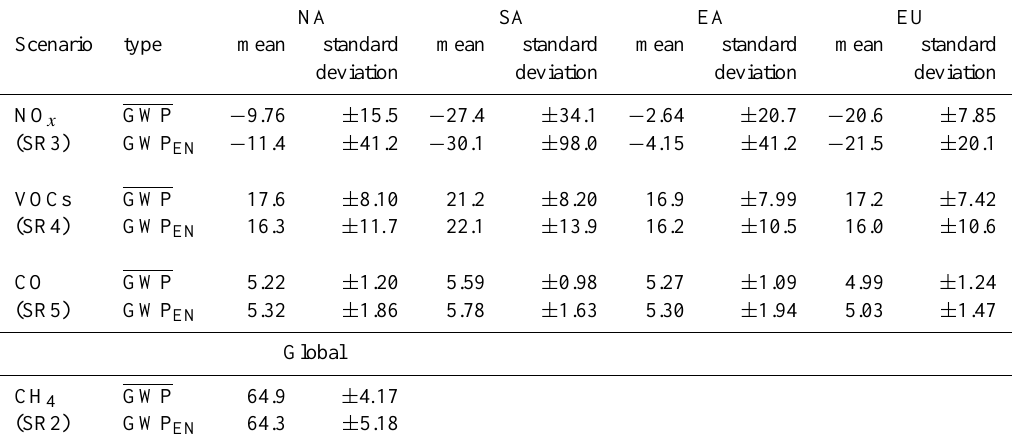
Table 5. As Table 4 for the 100 year GWP.